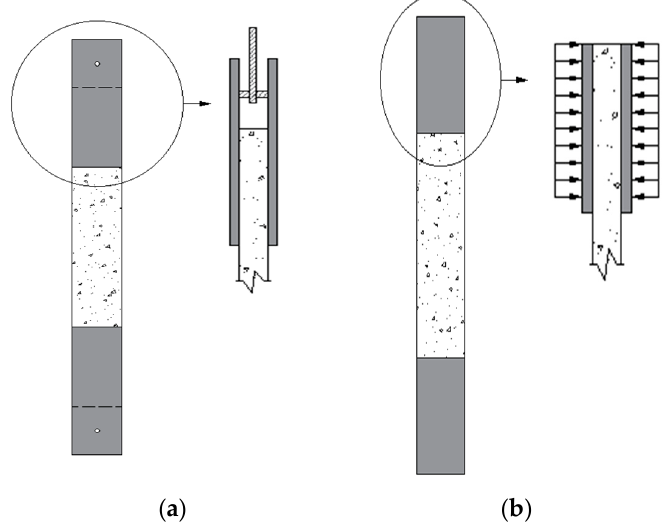
Figure 1. Sketch of ( a ) clevis-grip and ( b ) clamping-grip uniaxial tensile test set-ups.